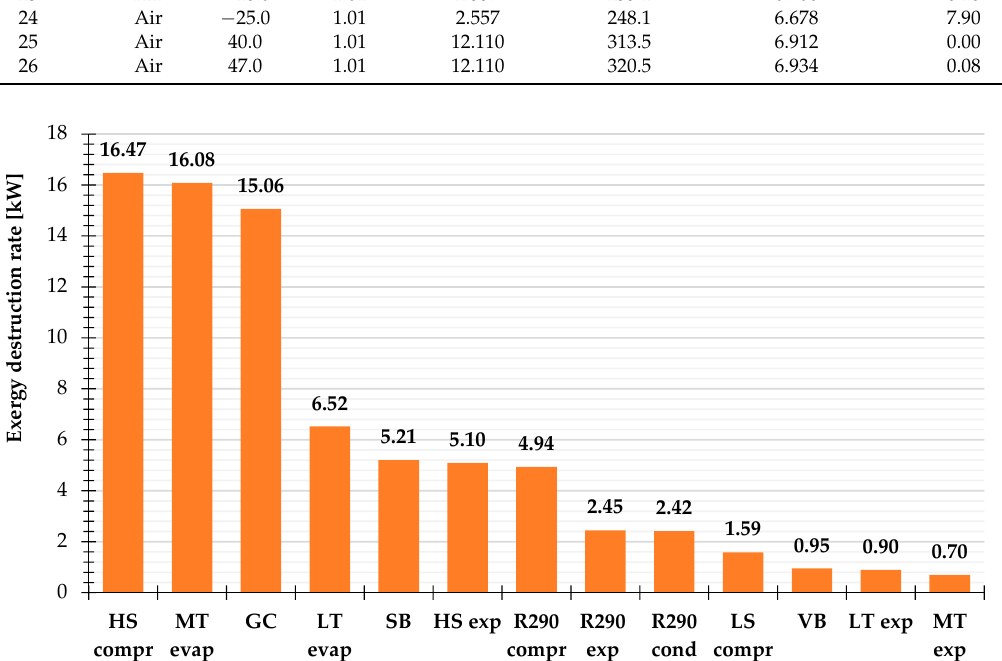
Figure 3. Exergy destruction rates of the components belonging to DMS at the outdoor temperature of 40 °C.